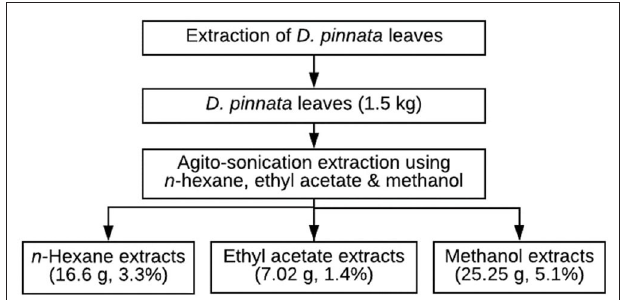
FIGURE 1 | Extraction steps of D. pinnata leaves.